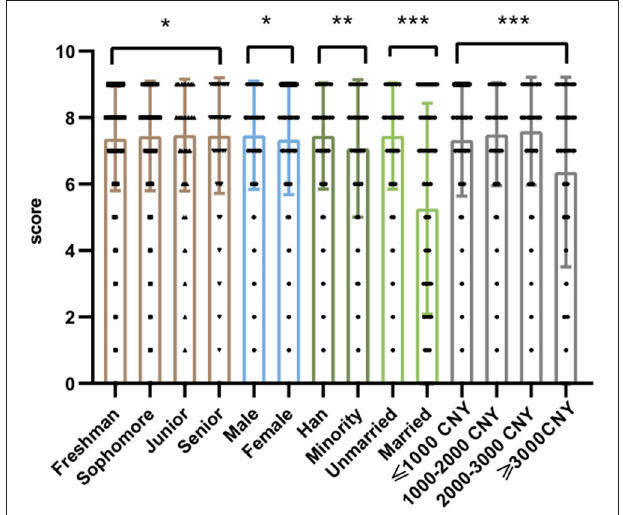
FIGURE 4 | Score of AIDS-related knowledge among college students. ns p > 0.05, * p < 0.05, ** p < 0.01, *** p < 0.001.